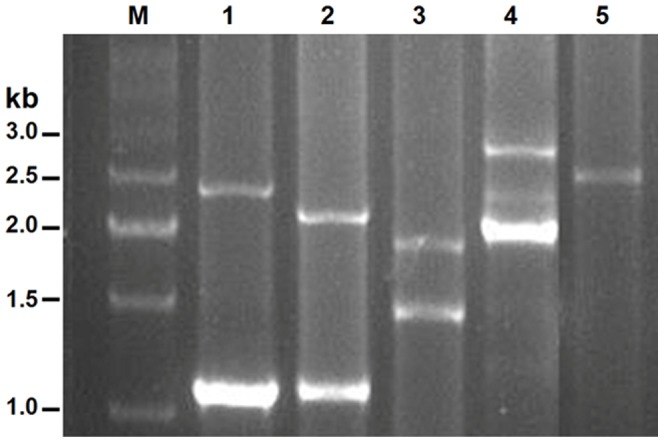
Representative alleles of MUC5AC-u repetitive region.
MUC5AC-u repetitive regions were PCR-amplified from blood genomic DNA of case and control samples using specific unique primers. Eight alleles with discontinuous sizes ranging from 1.1 to 2.8 kb were identified in this Han Chinese population. Lane 1: 1.1 kb/2.3 kb; lane 2: 1.1 kb/2.1 kb; lane 3: 1.4 kb/1.8 kb; lane 4: 2.0 kb/2.8 kb; lane 5: 2.5 kb/2.5 kb. M indicated the size marker.